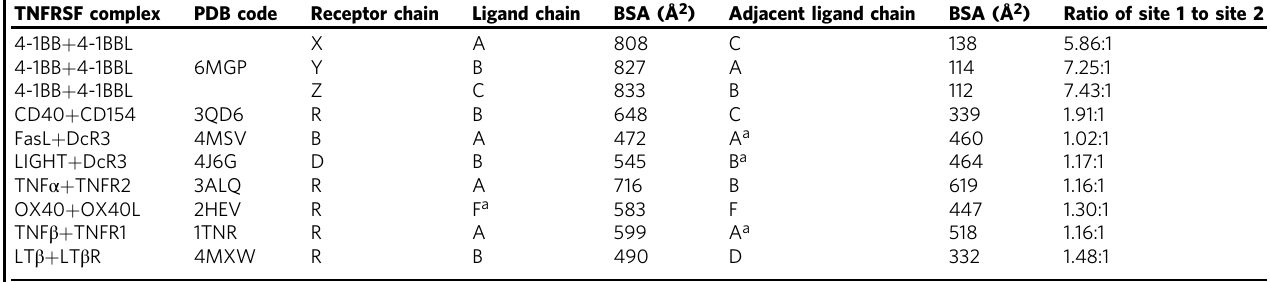
Table 1 Ratio of receptor – ligand binding site areas TNFRSF